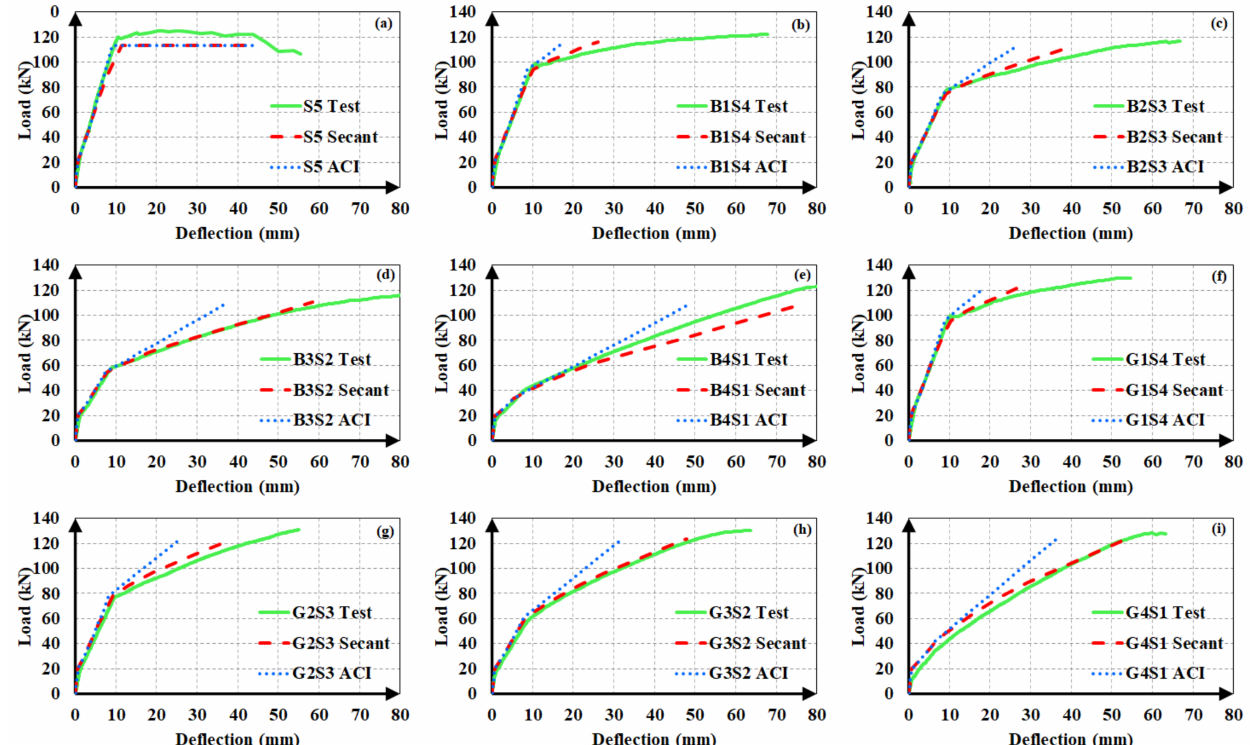
Figure 12. Experimental and analytical load-deflection curves of the first set of beams. ( a ) S5; ( b ) B1S4; ( c ) B2S3; ( d ) B3S2;